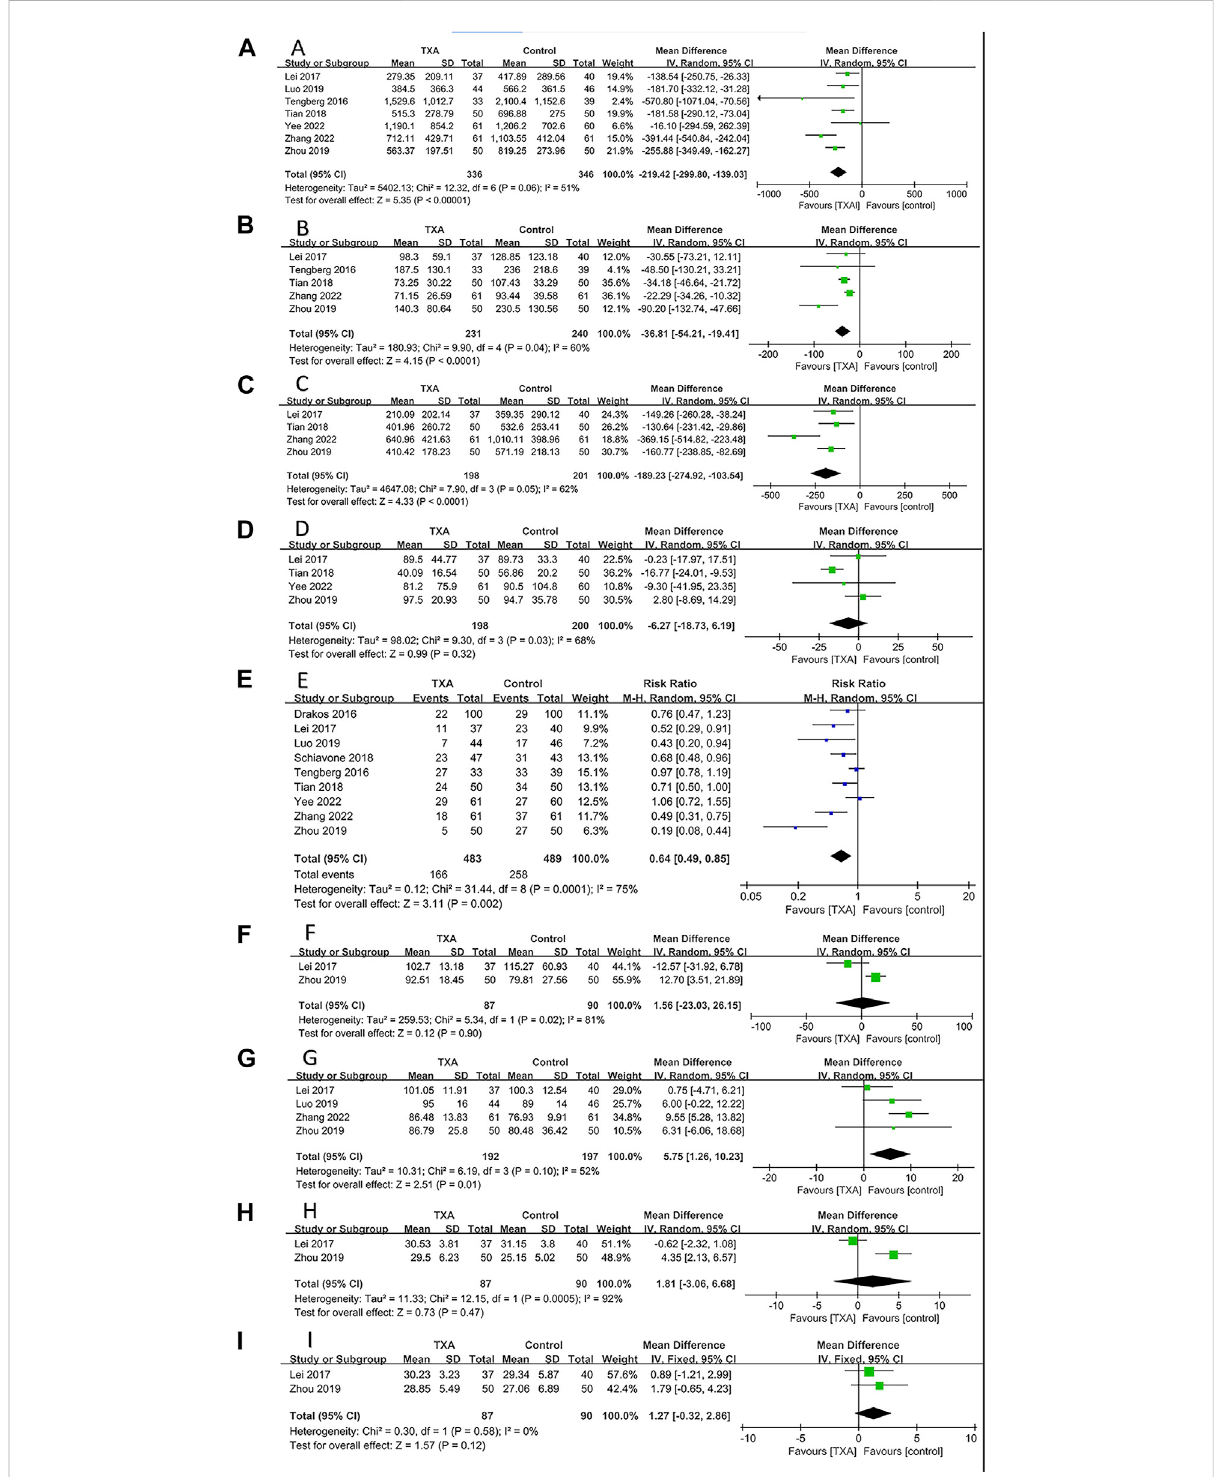
FIGURE 4 Forest plot showing bleeding-related outcomes of TXA group vs. control group. (A) Total blood loss. (B) Intraoperative blood loss. (C) Hidden bloodloss. (D) Postoperativedrainage. (E) Bloodtransfusionrate. (F) Postoperativehemoglobinonday1. (G) Postoperativehemoglobin onday3. (H) Postoperative hematocrit on day 1. (I) Postoperative hematocrit on day